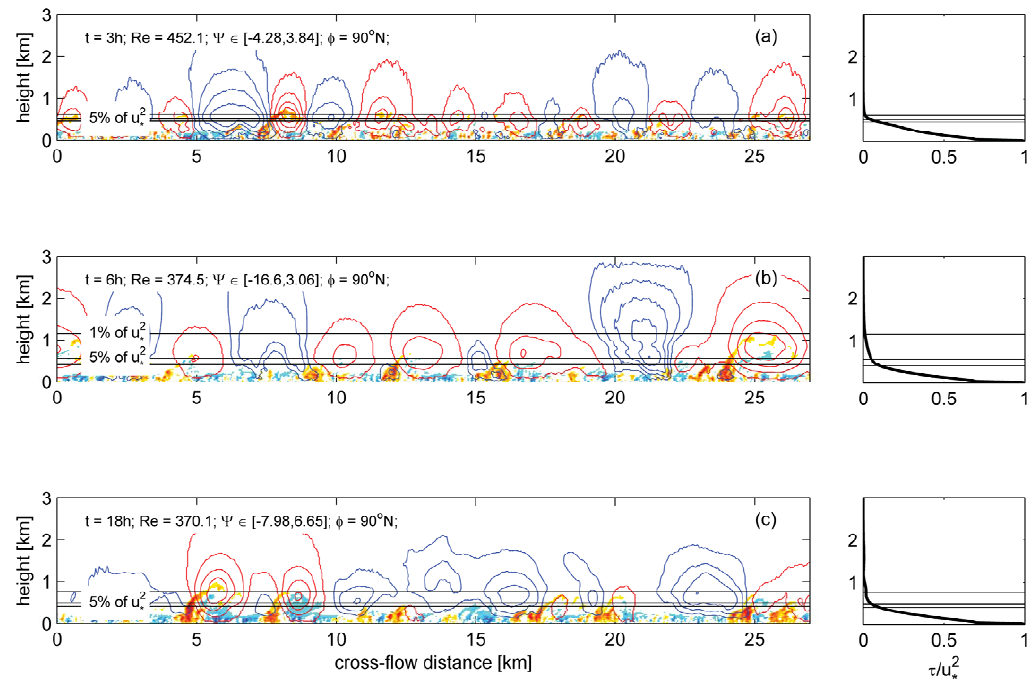
Fig. 11. Cross-flow sections ( yz planes) of the instant flow patterns in EW-EBL at 90 ◦ N. The panels are composed similarly to Fig.